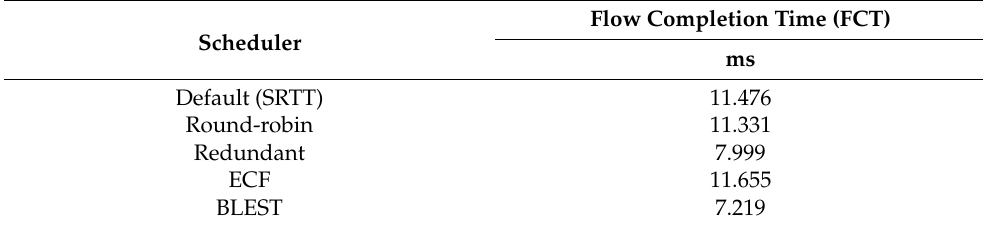
Table 2. Performance of the tested MPTCP schedulers in terms of FCT for LIA as a CCA.